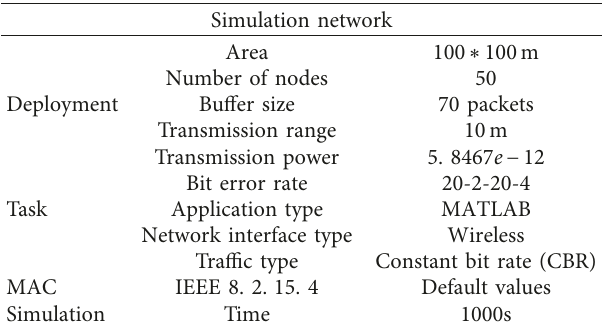
Table 1: Simulation